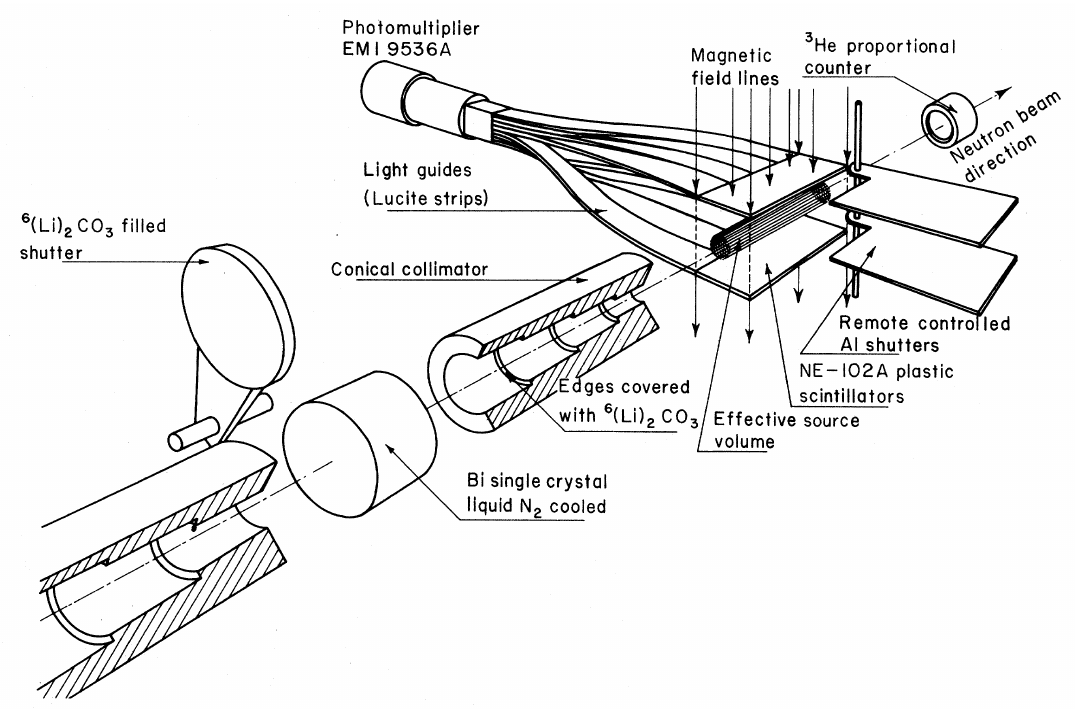
Figure 1. The Risö neutron lifetime experiment [21]. The decay volume is defined by two parallel plastic scintilator paddles within a uniform magnetic field.